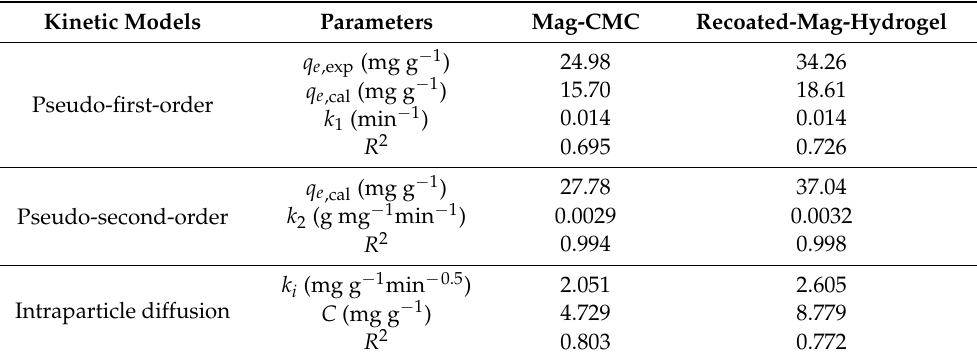
Table 3. Adsorption kinetic parameters for the adsorption for MB